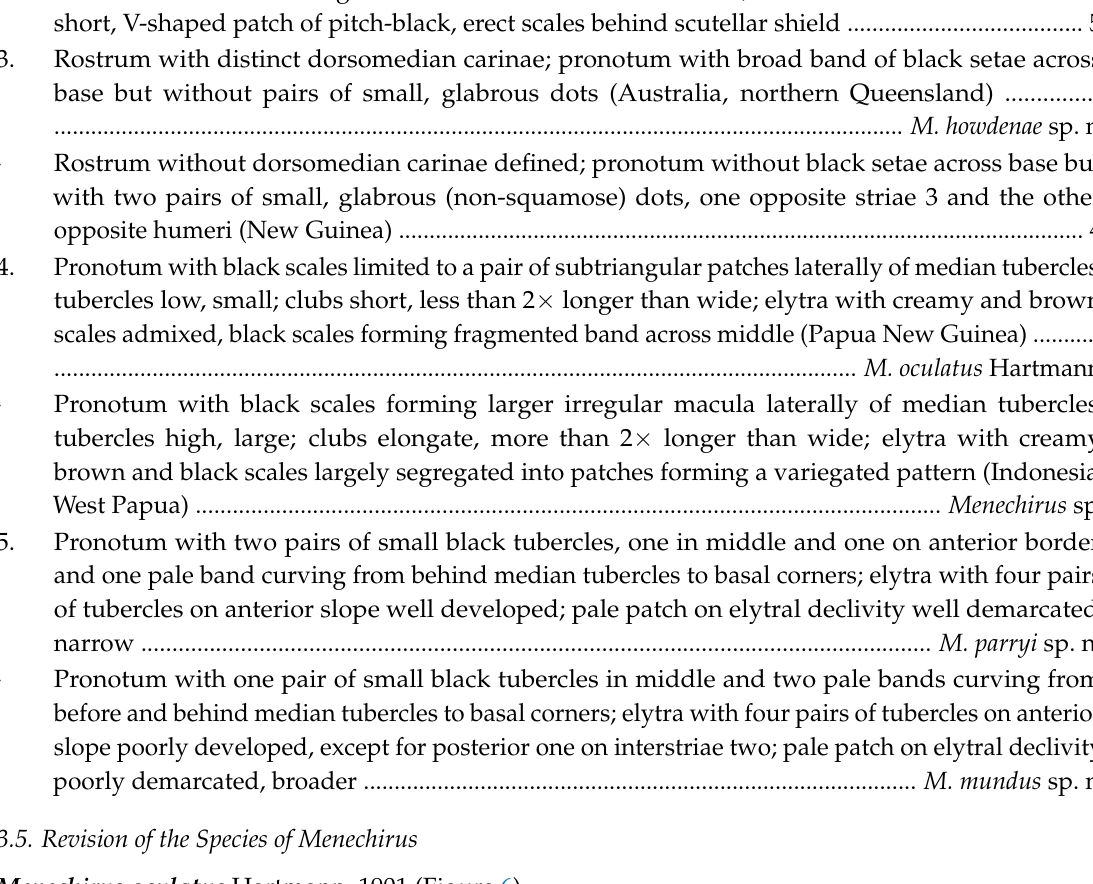
- Body length < 5 mm; pronotum with small pair of central tubercles and pale setae forming one to two narrow bands arching from bases across central tubercles; sutural interstriae in male with short, V-shaped patch of pitch-black, erect scales behind scutellar shield ...................................... 5 3. Rostrum with distinct dorsomedian carinae; pronotum with broad band of black setae across base but without pairs of small, glabrous dots (Australia, northern Queensland) ................ - Rostrum without dorsomedian carinae defined; pronotum without black setae across base but with two pairs of small, glabrous (non-squamose) dots, one opposite striae 3 and the other 4. Pronotum with black scales limited to a pair of subtriangular patches laterally of median tubercles; tubercles low, small; clubs short, less than 2 × longer than wide; elytra with creamy and brown scales admixed, black scales forming fragmented band across middle (Papua New Guinea) ............ - Pronotum with black scales forming larger irregular macula laterally of median tubercles; tubercles high, large; clubs elongate, more than 2 × longer than wide; elytra with creamy, brown and black scales largely segregated into patches forming a variegated pattern (Indonesia, 5. Pronotum with two pairs of small black tubercles, one in middle and one on anterior border, and one pale band curving from behind median tubercles to basal corners; elytra with four pairs of tubercles on anterior slope well developed; pale patch on elytral declivity well demarcated, - Pronotum with one pair of small black tubercles in middle and two pale bands curving from before and behind median tubercles to basal corners; elytra with four pairs of tubercles on anterior slope poorly developed, except for posterior one on interstriae two; pale patch on elytral